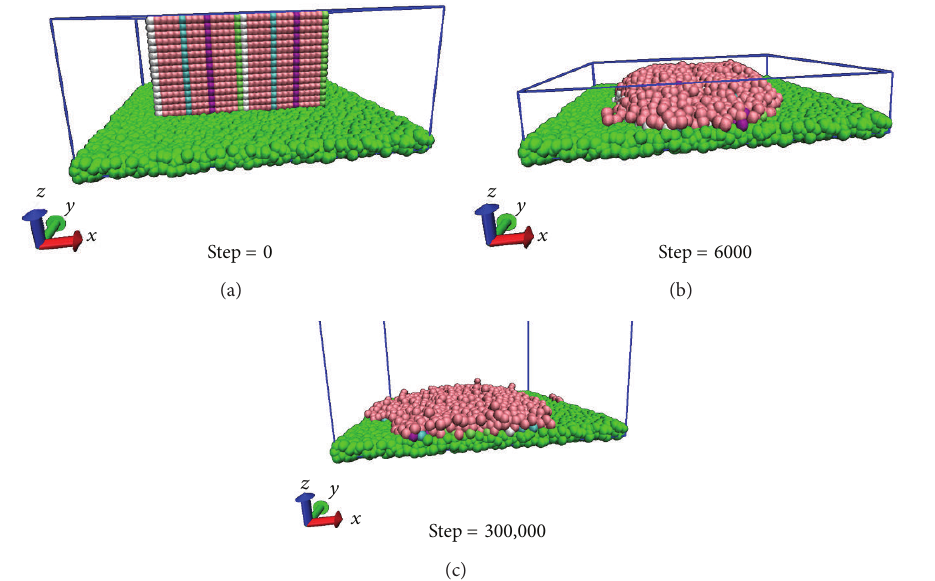
Figure 17: Snapshots of OHJ-DS on DLC surface at different time steps: (a) step = 0; (b) step = 6000; (c) step = 300,000 at temperature 𝑇 ∗ = 4 (668 K = 395 ∘ C) with bond